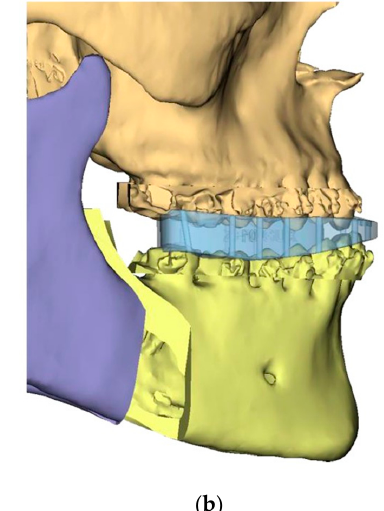
Figure 4. Surgical Plan: Maxilla movement overview (osteotomy thickness of 0.1 mm: ( a ) Right side view; ( b ) Left side view; ( c ) Frontal view.